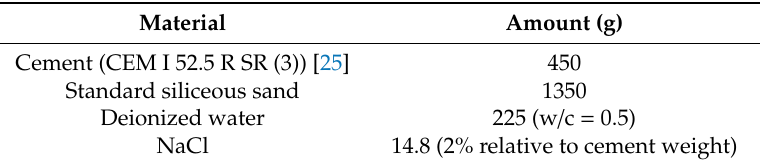
Table 1. Composition of the cement mortar.